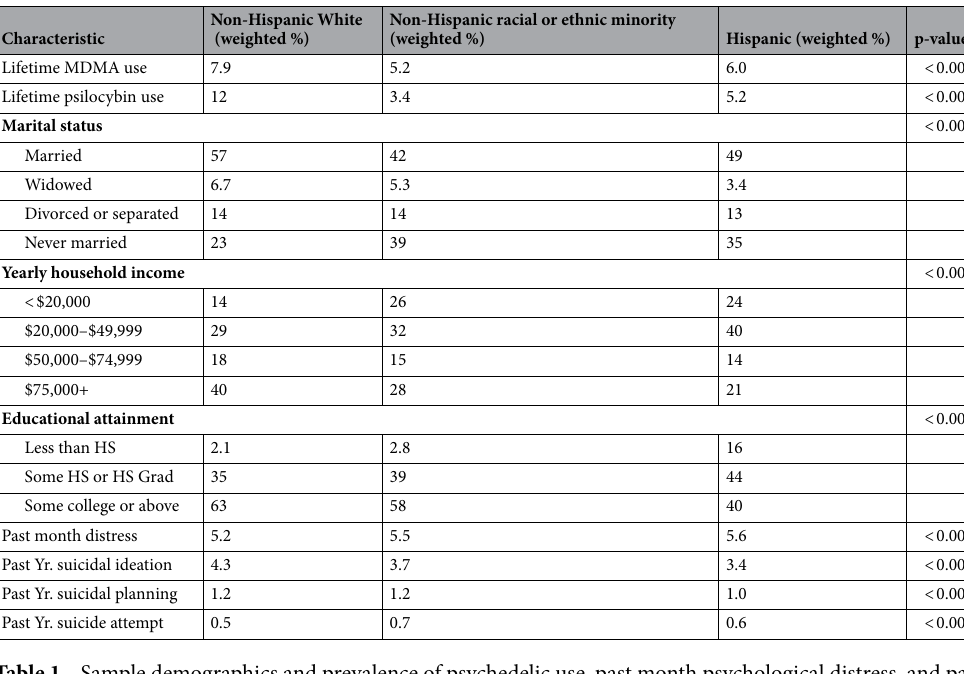
Past Mo. distress Past Yr. S.I Past Yr.